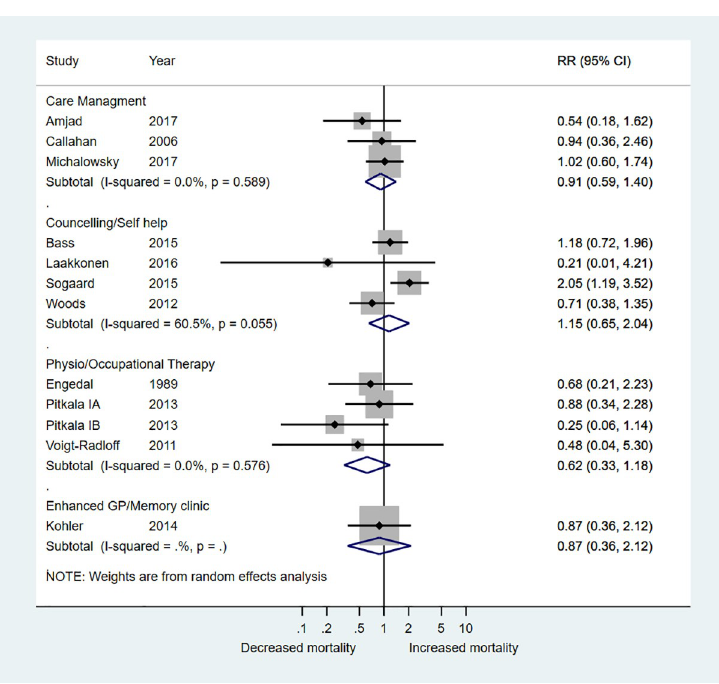
Fig 4. Forest plot relative risk (RR) of death stratified according to type of intervention.